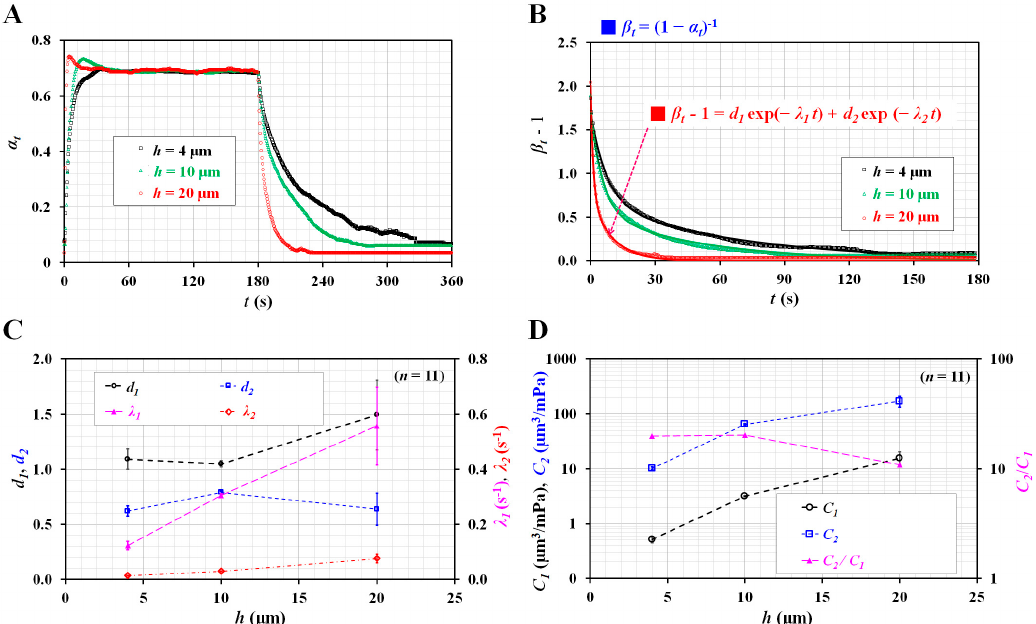
Figure 3. Contribution of channel depth to compliance. ( A ) Temporal variations of α t with respect to channel depth ( h ) ( h = 4, 10, and 20 µm). ( B ) Variation of ( β t –1) with respect to h . On the basis of the relationship β t = (1 − α t ) − 1 , the nonlinear regression formula was assumed as ( β t -1) = d 1 exp (– λ 1 t ) + d 2 exp (– λ 2 t ). ( C ) Variations of four constants (i.e., d 1 , d 2 , λ 1 , and λ 2 ) with respect to h . ( D ) Variations of C 1 , C 2 , and C 2 / C 1 with respect to h .